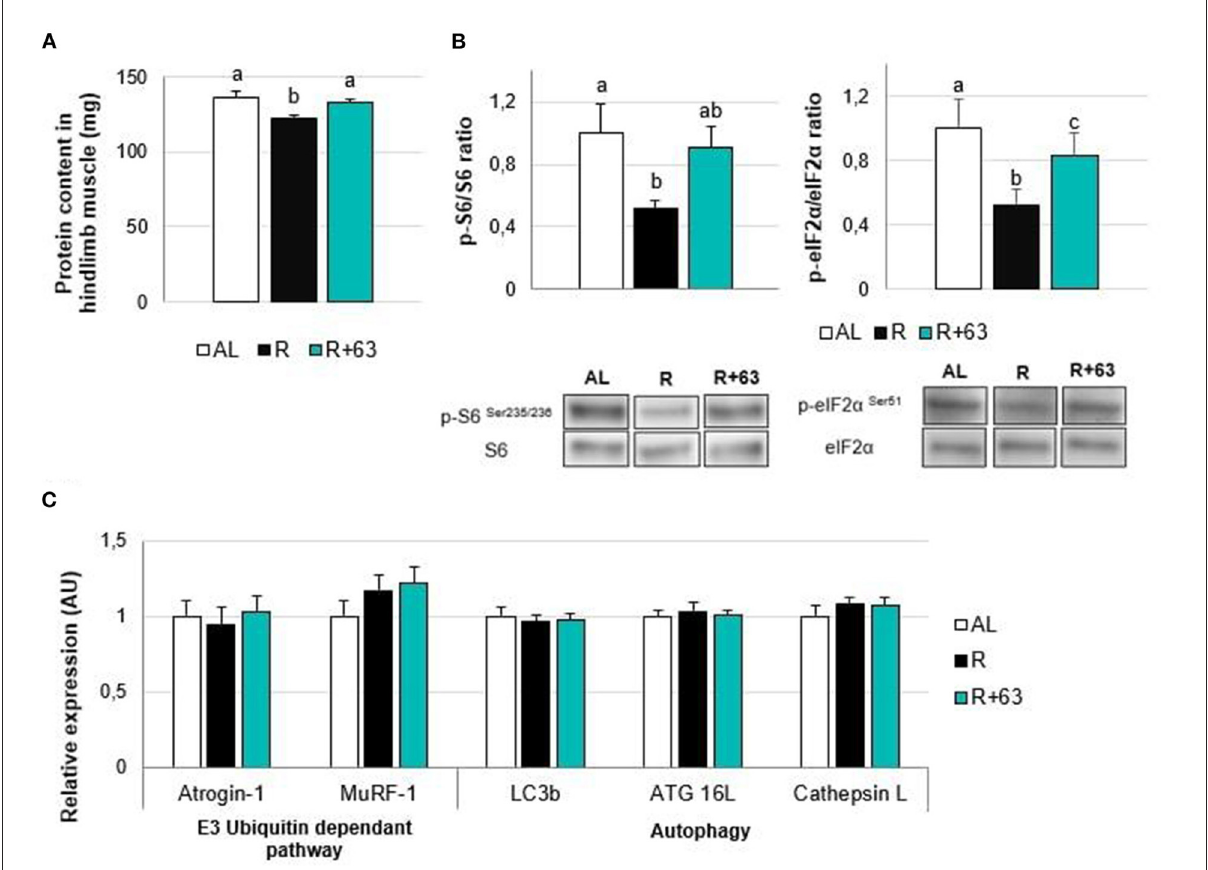
FIGURE6 Levels of protein, insulin pathway mediators, and proteolysis-related gene expression in the muscles of 18-month-old rats fed an ad libitum (AL) diet or a food-restricted (R) diet over a one-month period; one food-restricted group received a probiotic supplement – strain 63 (R+63). (A) Protein levels in hindlimb muscles (gastrocnemius, soleus, tibialis anterior, and extensor digitorum longus). (B) Levels of proteins involved in the AKT/mTOR/S6K pathway: ratio of phosphorylated proteins, p-S6 (Ser235/236), and p-eIF2 α (Ser51), to total proteins, S6 and eIF2 α . (C) Expression levels of muscle proteolysis genes, namely those related to the regulation of the ubiquitin-proteasome-dependent pathway (Atrogin-1 and MuRF-1) and autophagy pathway (Lc3b, ATG16L, and Cathepsin L). Values are means ± SEM. Differences in letters indicate a significant difference between groups (Kruskal–Wallis test and Dunn’s post hoc test, p ≤ 0.05, n = 61